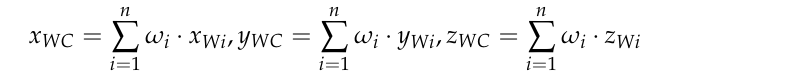
Figure 5. Coordinate system transformation diagram.